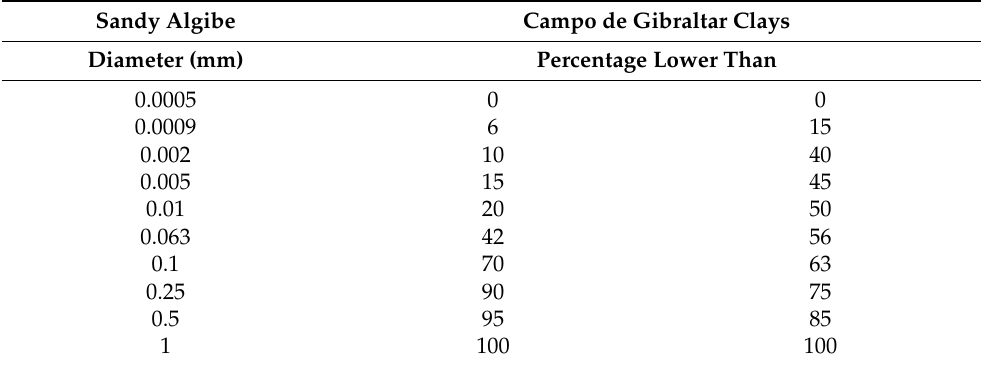
Table 2. Soil units